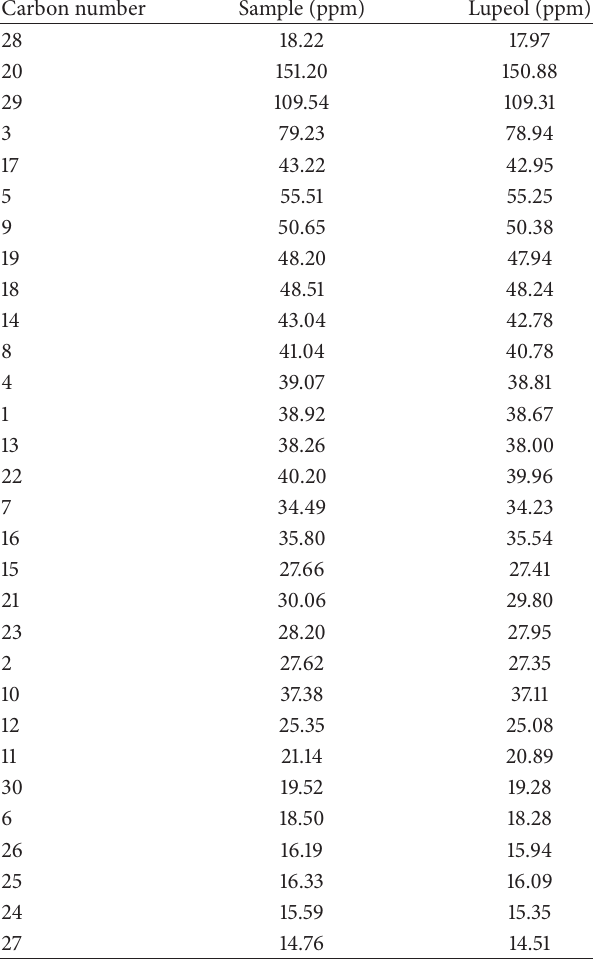
Table 3: NMR analysis of the ethyl acetate extract from C. macrostachyus stem bark 1 . Chemical shifts of the numbered carbon atoms are shown. Numbering of the carbon atoms used is that of triterpene